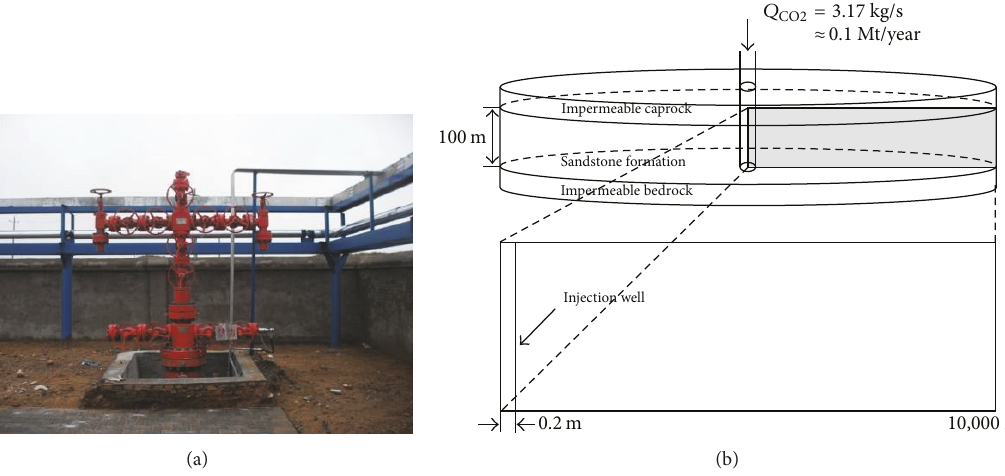
Figure 1: (a) Injection well (Zhongshenzhu 1) at the Shenhua CCS site and (b) schematic diagram of the 2D model.